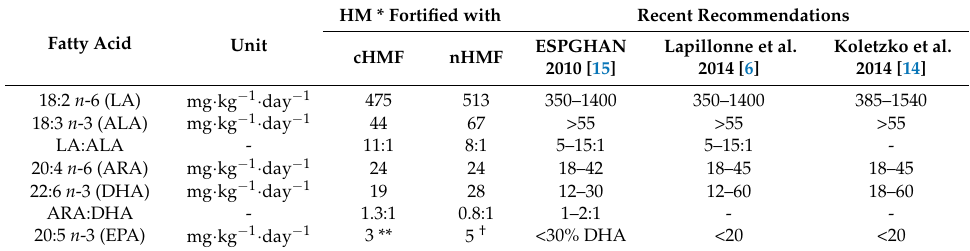
Table 3. Estimated levels of essential and long-chain polyunsaturated fatty acids provided by human milk (HM) fortified with a control (cHMF) or a new human milk fortifier (nHMF) in preterm infant